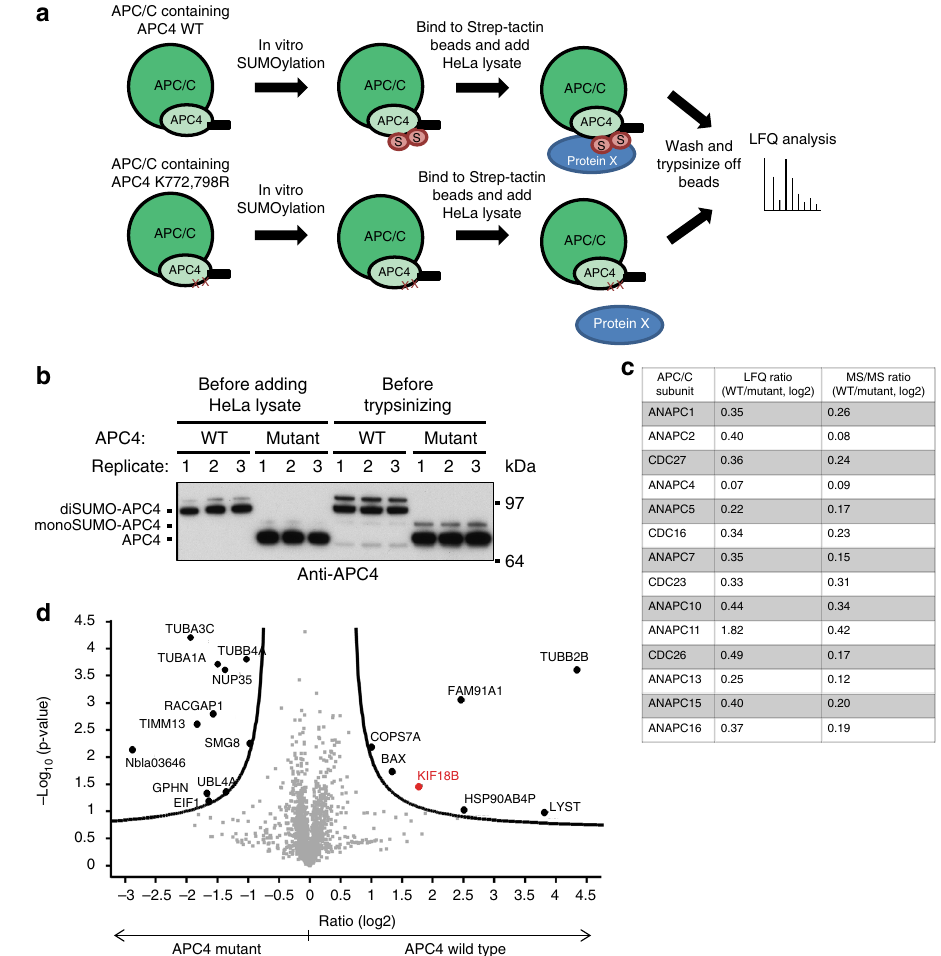
Fig. 6 Mass spectrometric analysis identi fi es KIF18B to preferentially bind to SUMOylated APC/C. a Schematic overview on the mass spectrometric approach designed to identify differences in the interactomes of SUMOylated versus non-SUMOylated APC/C: Recombinant APC/C containing either APC4 wild type or APC4 K772,798R mutant, was SUMOylated in vitro. The complex was bound to Strep-tactin beads via a C-terminal Strep-tag on APC4 and the SUMOylation machinery was washed away. HeLa cells were lysed in buffer containing NEM to inhibit SUMO proteases and lysates were added to the wild- type and mutant complexes. After mild washing, proteins were trypsinized and the resulting peptides were subjected to mass spectrometry. Data were obtained from three biological repeats measured in three technical repeats each. b To monitor the SUMOylation levels of APC4 wild type (WT) and APC4 K772,798R mutant before and after adding the HeLa lysate, samples were taken at the respective steps and immunoblotted with anti-APC4 antibody. c The table depicts the different subunits of the APC/C identi fi ed in the mass spectrometric analysis and the respective label-free quanti fi cation (LFQ) and MS/MS (spectral counting) ratios in log2, visualizing that there is no signi fi cant difference between the composition of the wild-type complex (WT) and the complex containing the APC4 SUMOylation-de fi cient mutant. d Volcano plot showing the log 2 ratio of the protein intensities obtained by puri fi cation with wild-type APC4 compared to the intensities obtained with mutant APC4 on the x axis versus the negative p -value (log 10 ) calculated from a permutation-based false discovery rate on the y axis. Proteins that were either upregulated in the wild-type samples or upregulated in the mutant samples are displayed as large black dots. KIF18B, shown in red, is upregulated in the wild-type sample, indicating that it preferentially bound to SUMOylated novel APC/C target KIF18B was increased, ubiquitylation of Securin was not altered (Supplementary Fig. 7E).